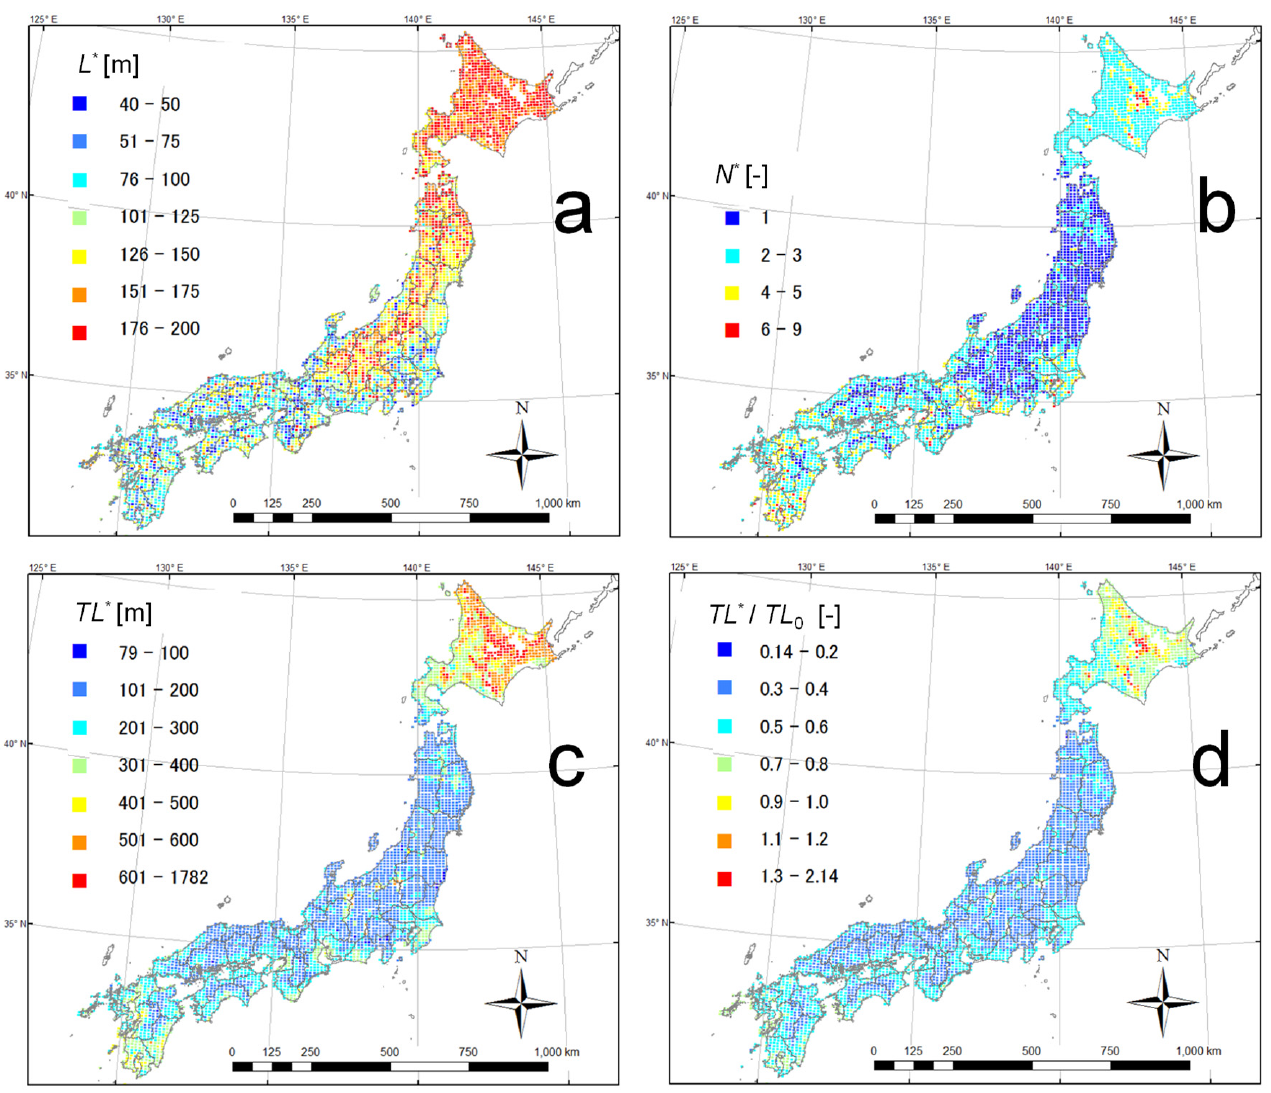
Figure 6. Simulation results of required length of each BHE L * ( a ), total number of BHEs N * ( b ), total length TL * ( c ), and the reduction ratio compared with conventional total length TL */ TL 0 ( d ).